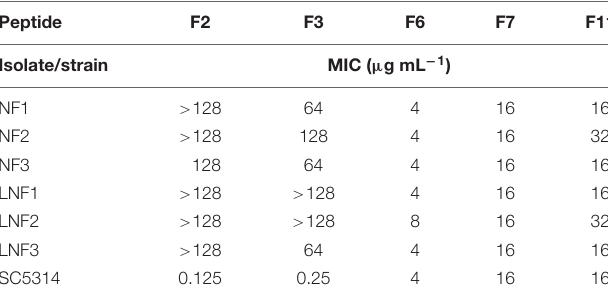
TABLE 8 | Anticandidal in vitro activity of FMDP-oligopeptides against isolates resistant to F2 and F3, determined in YNB-SG medium.